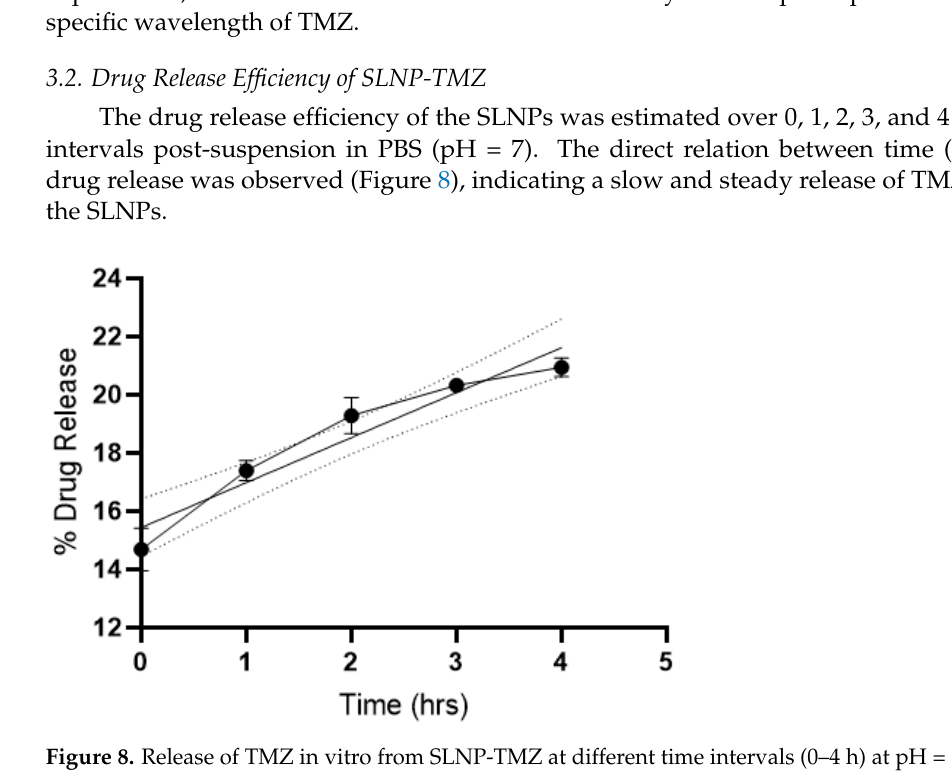
Figure 9. Morphology of U87-MG cells (U87-S) (100X magnification); ( A ) Before ( B ) After treatment with periodic exposure to temozolomide produces a chemo-resistant phenotype with longer extru- sions and irregular shapes. 3.3.1. Confirmation of Establishment of Resistance in U87-R The establishment of a resistant cell line (U87-R) from TMZ-sensitive U87-S was con- firmed by evaluating the expression of MGMT and STAT3 markers [25,26]. Significant elevation in MGMT ( p = 0.0068) and STAT3 ( p = 0.0307) mRNA expression, quantified by qRT PCR, confirmed the resistant nature of the U87-R cell line (Figure 10).